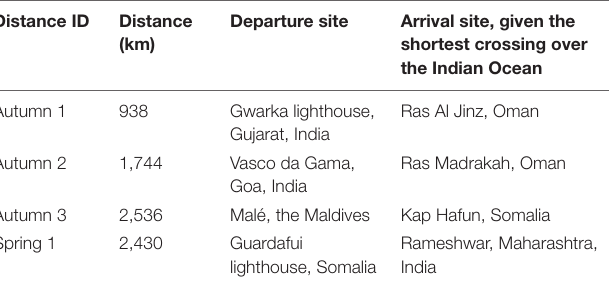
TABLE 1 | Four minimum distances across the Indian Ocean, based on starting points corresponding to the four departure sites used in the wind trajectory analyses of potential globe skimmer autumn and spring migration